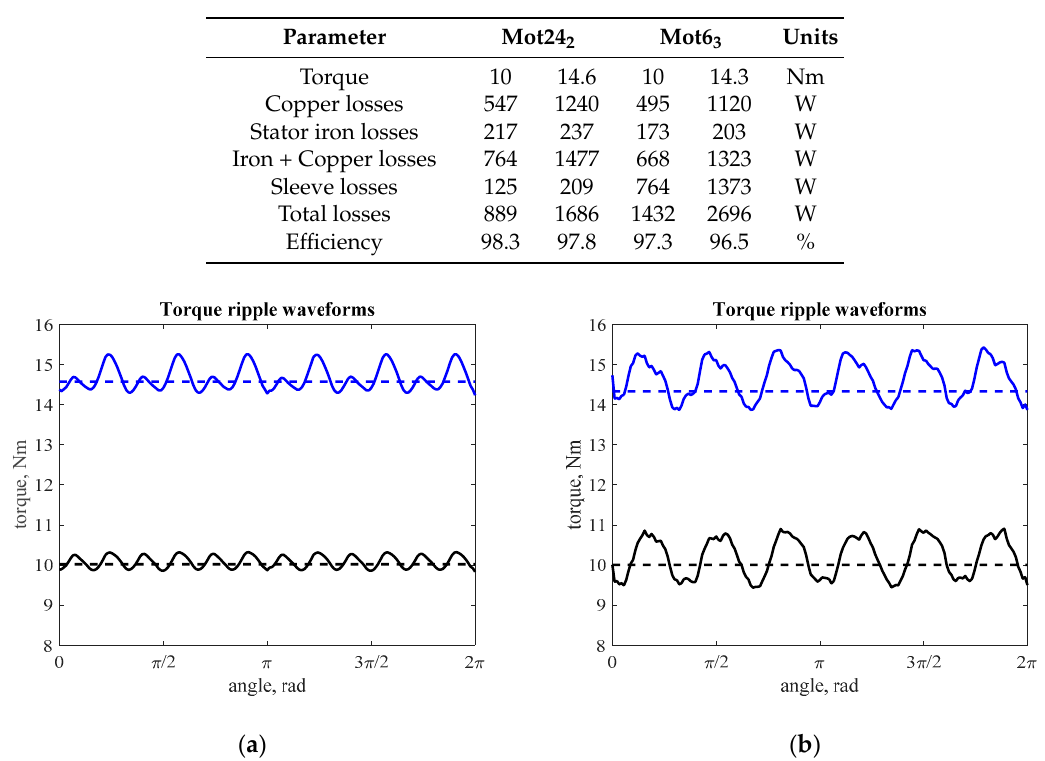
Figure 9. Torque ripple for the DW Mot24 2 ( a ) and for the CW Mot6 3 ( b ) machines at rated current and 1.5 overload.